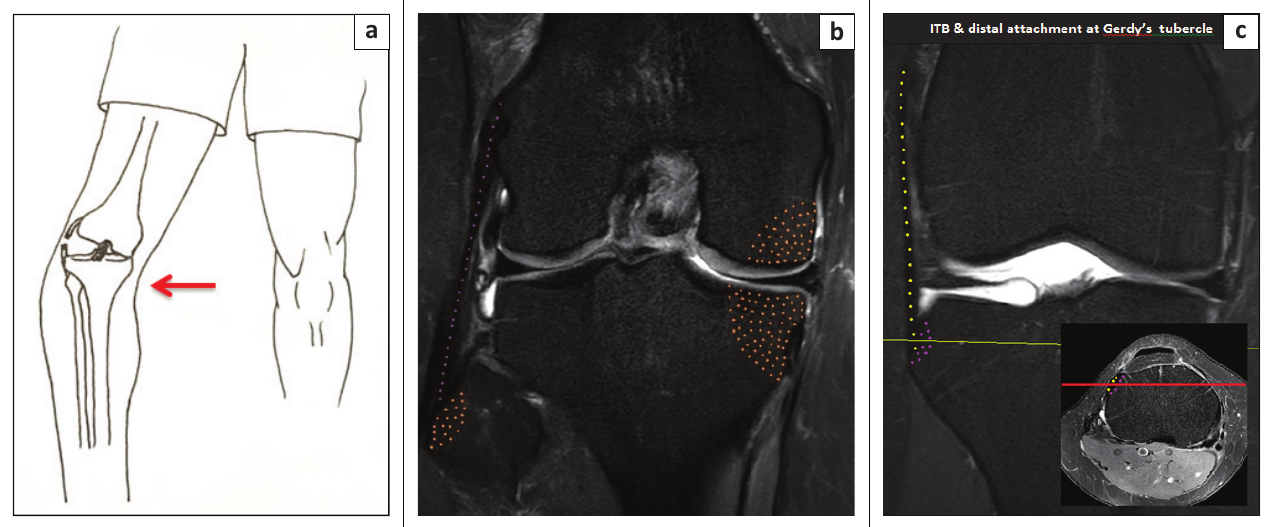
FIGURE 5: Pure varus: (a) Schematic depicts laterally directed force, (b) right knee medial tibia and femoral condyle impactions, and lateral collateral ligament injury, possibly with fibular head avulsion oedema, and (c) iliotibial band injury with possible avulsion oedema at Gerdy’s tubercle.